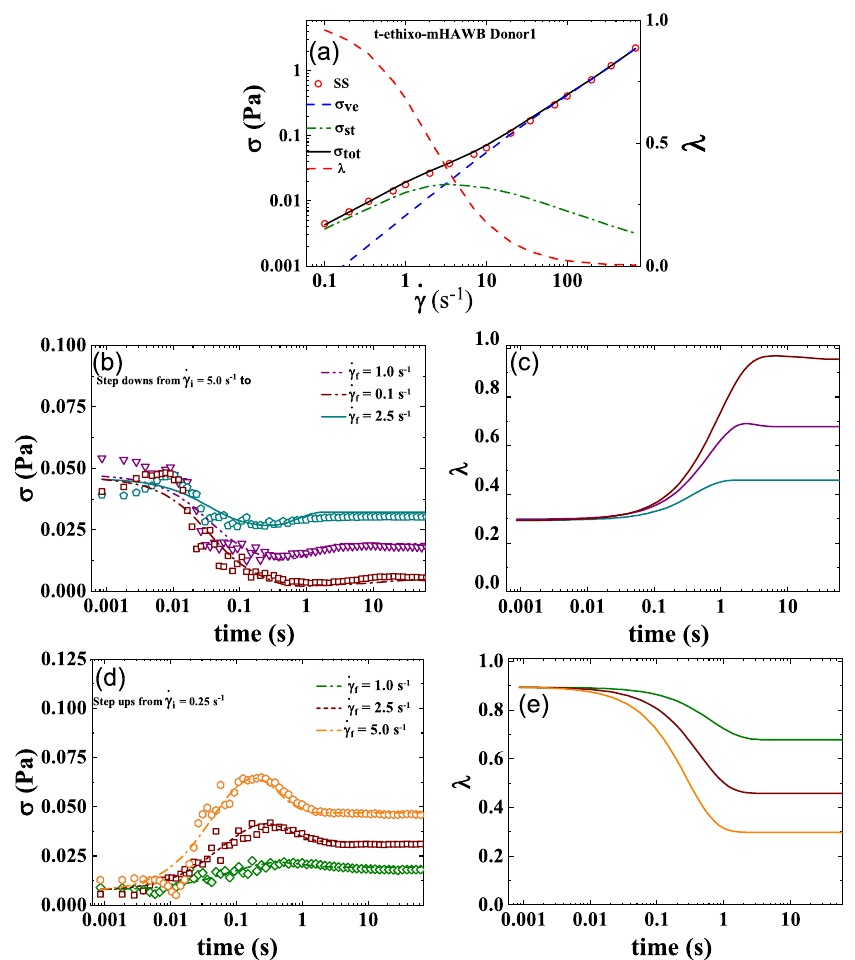
Figure 2. t-ethixo-mHAWB fits to ( a ) steady state; ( b ) series of step downs from ˙ γ = 5 s −1 to 2.5, 1, 0.5 s −1 ; ( c ) representative structure parameter curves with colors corresponding to prior stress evolution curves; ( d ) step up in shear rate from ˙ γ = 0.25 s −1 to 1, 2.5, 5 s −1 ; and ( e ) representative structure parameter curves (Donor 1, Dataset 1) 49